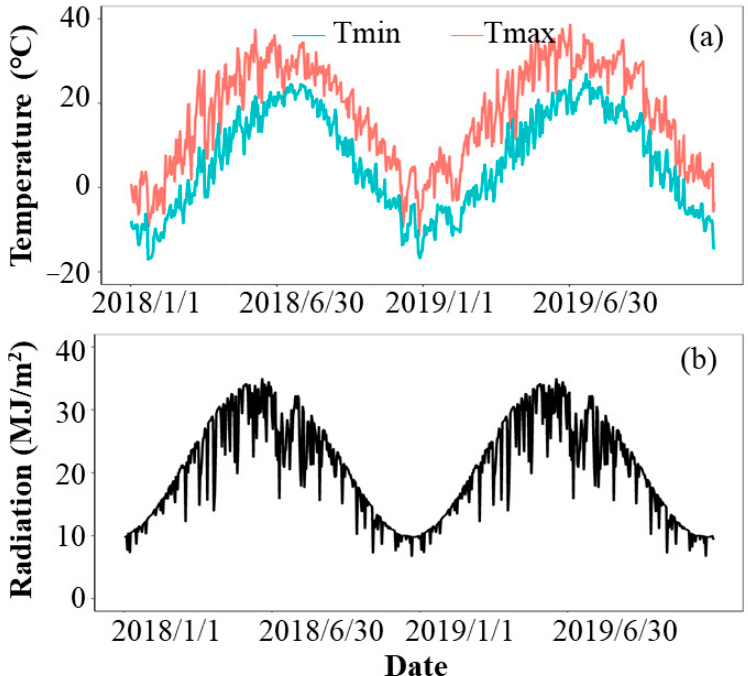
Figure 2. Daily temperature ( a ) and radiation ( b ) during 2017~2019 in field experiments.